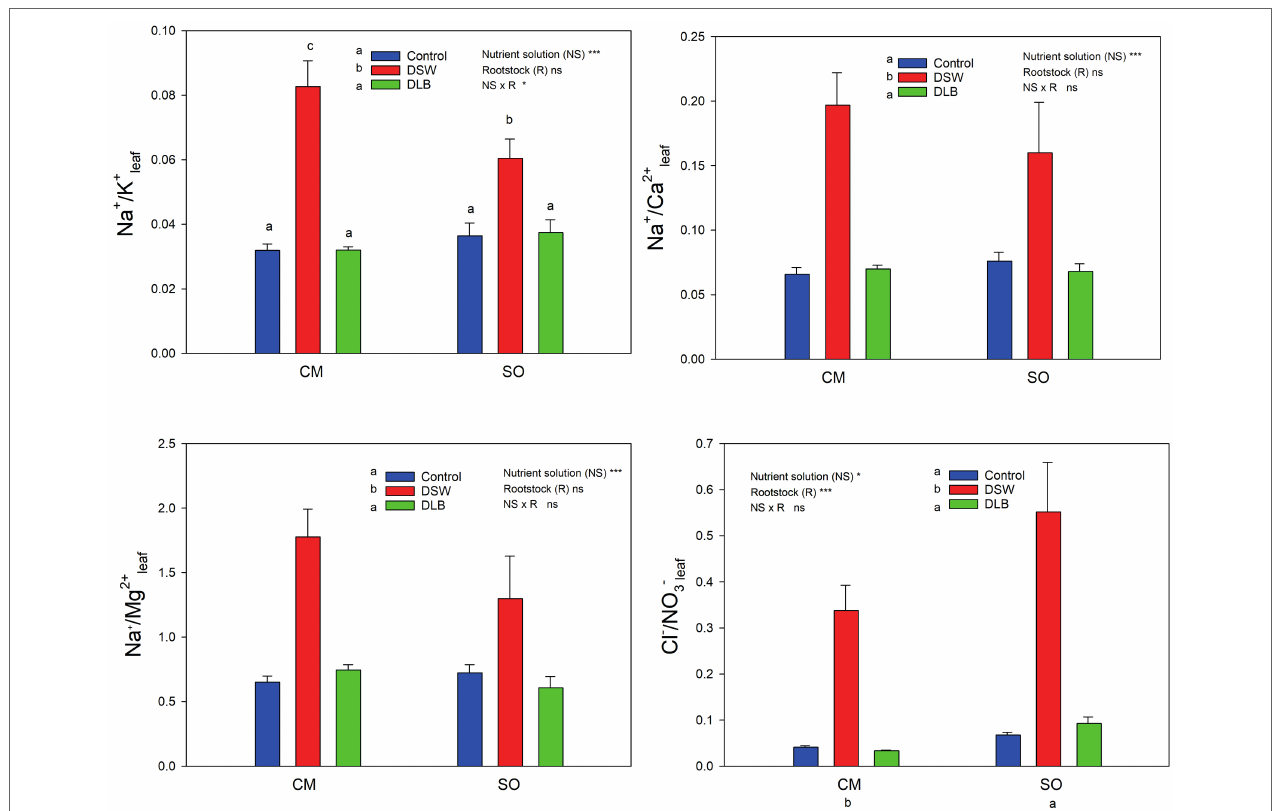
FIGURE 5 | Effects of 7 months of irrigation with nutrient solutions of different characteristics—Control, DSW, and DLB—on different ratios of ionic concentrations (Na + or Cl − and essential nutrients) in leaves of ‘Verna’ lemon plants grown on two rootstocks, Citrus macrophylla (CM) and sour orange (SO). Different letters indicate significant differences according to Duncan’s multiple range test at the 95% confidence